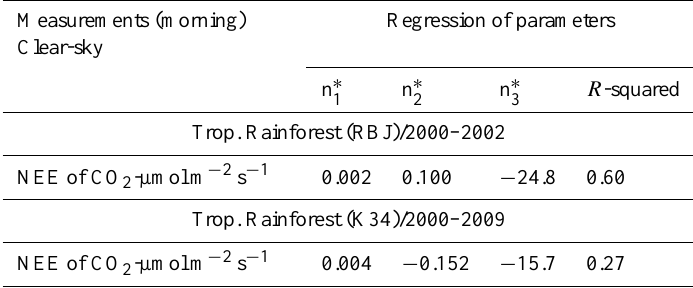
Table 3. Regression coefficients of relationship between NEE and solar zenithal angle (SZA) for clear-sky conditions ( f ∼ 1.0) observed during the year at the K34 and RBJ sites. The fitted equation is NEE = n 3 + n 2 ( SZA ) + n 1 ( SZA ) 2 . Measurements (morning) Regression of Clear-sky